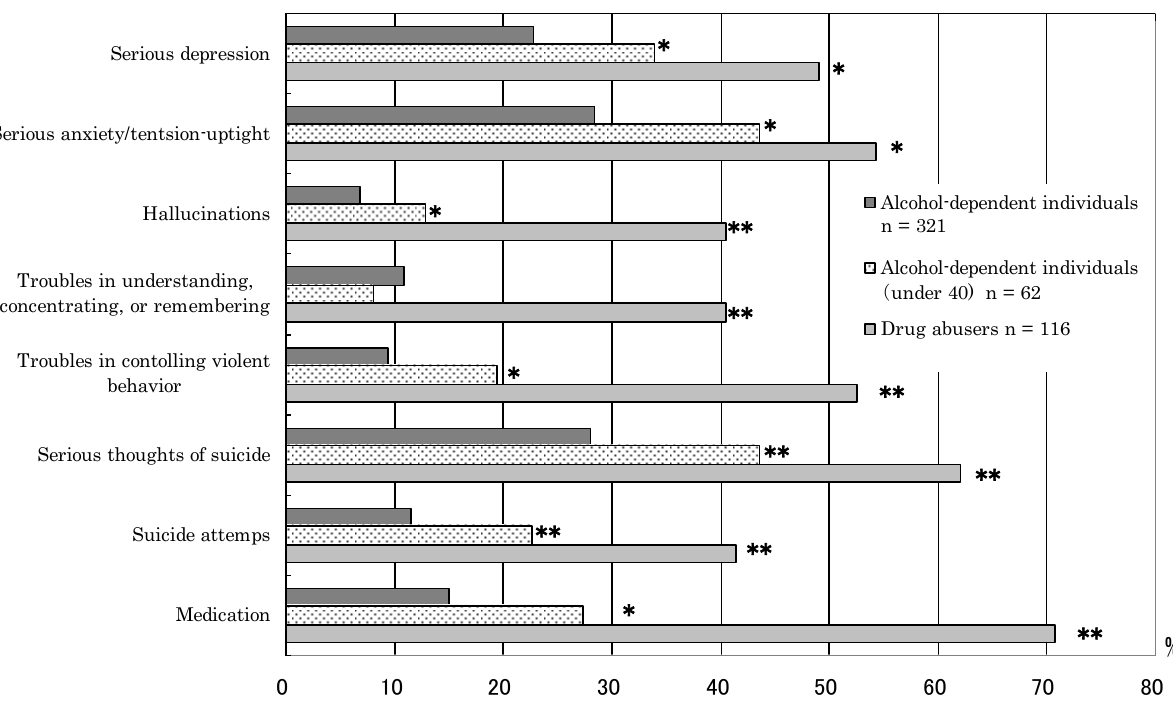
Figure 2. Comparison of lifetime prevalence of psychiatric problems between alcohol-dependent individuals and drug